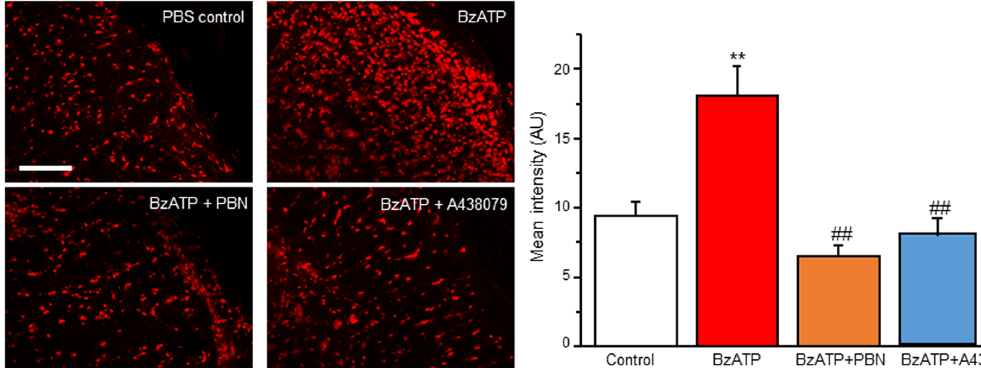
Figure 5. BzATP increases ROS in the spinal cord dorsal horn in vivo . Left panel: Confocal images of BzATP- induced ROS production in the presence and absence of PBN and A438079. Right panel: Summary of the effects of A438079 and PBN on BzATP-induced ROS production. Values represent mean ± SEM, n = 3–6. ** P < 0.01 when compared to control, ## P < 0.01 when compared to BzATP by the one-way ANOVA. Scale bar 100 µ